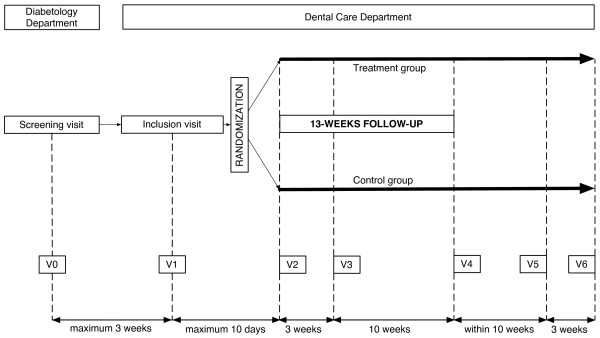
Study timelines.